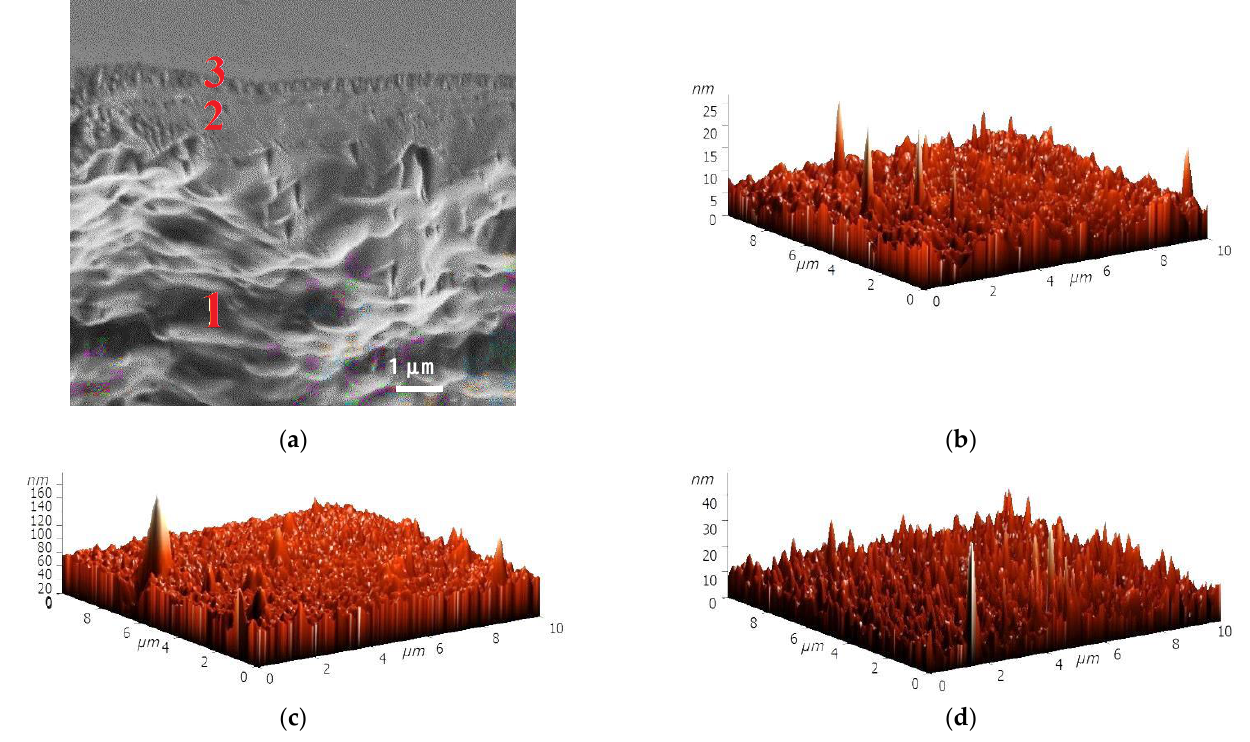
Figure 7. ( a ) A cross-sectional SEM micrograph of the SA-5HF/PAN CaCl2 -5Lbl PSS/SA membrane and surface AFM images for the ( b ) SA/PAN CaCl2 -5Lbl PSS/SA , ( c ) SA-5AF/PAN CaCl2 -5Lbl PSS/SA , and ( d ) SA-5HF/PAN CaCl2 -5Lbl PSS/SA membranes.